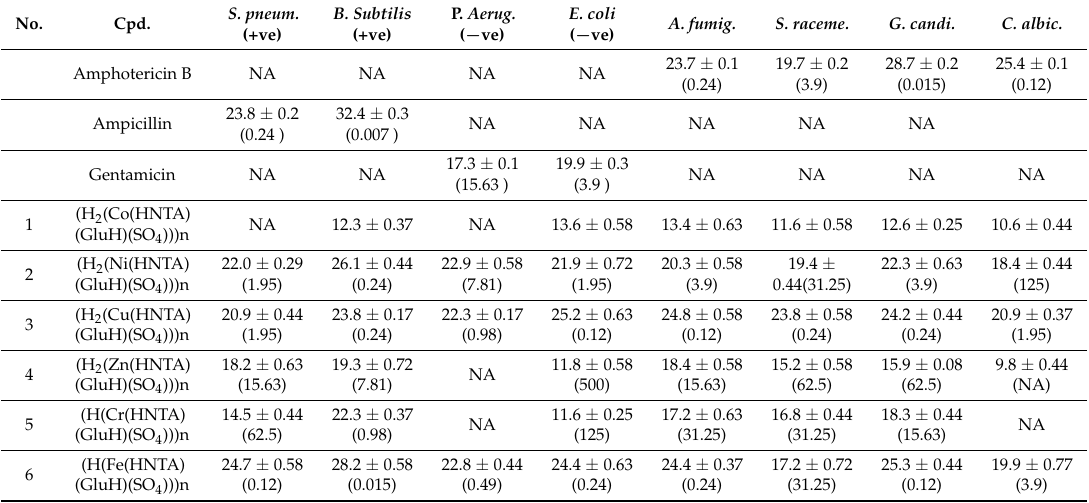
Table 8. The antimicrobial activity of the prepared ternary metal complexes containing oligomers. No.